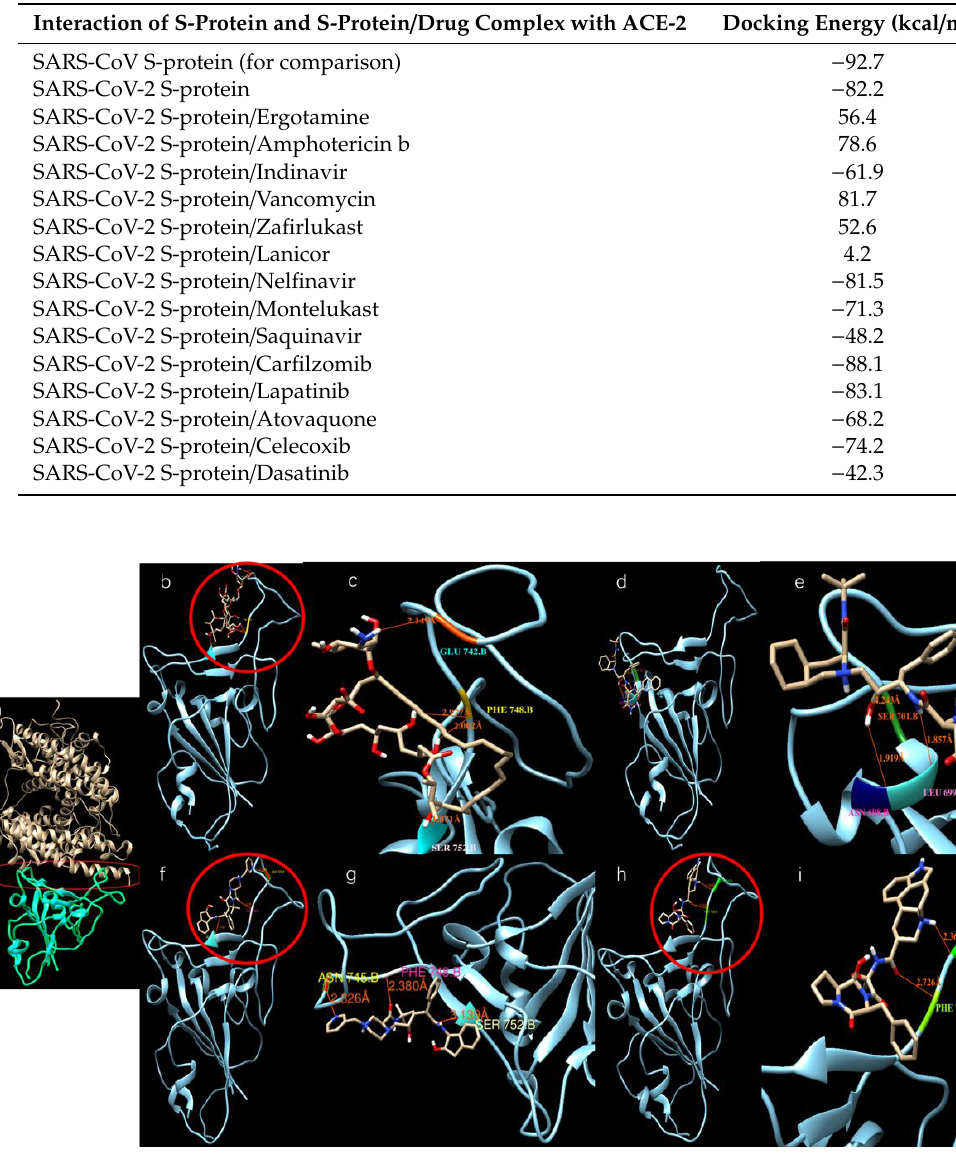
Figure 3. Potential active site selection and ligand-receptor interaction. ( a ) The docking site (inside the red frame) was chosen between the ACE-2 (light brown color) and SARS-CoV-2 S-protein (Cyan color); ( b ), ( c ) Amphotericin b docks onto the SARS-CoV-2 S-protein; ( d ), ( e ) Saquinavir docks onto the SARS-CoV-2 S-protein; ( f ), ( g ) Indinavir docks onto the SARS-CoV-2 S-protein; ( h ), ( i ) Ergotamine binds onto the SARS-CoV-2 S-protein.